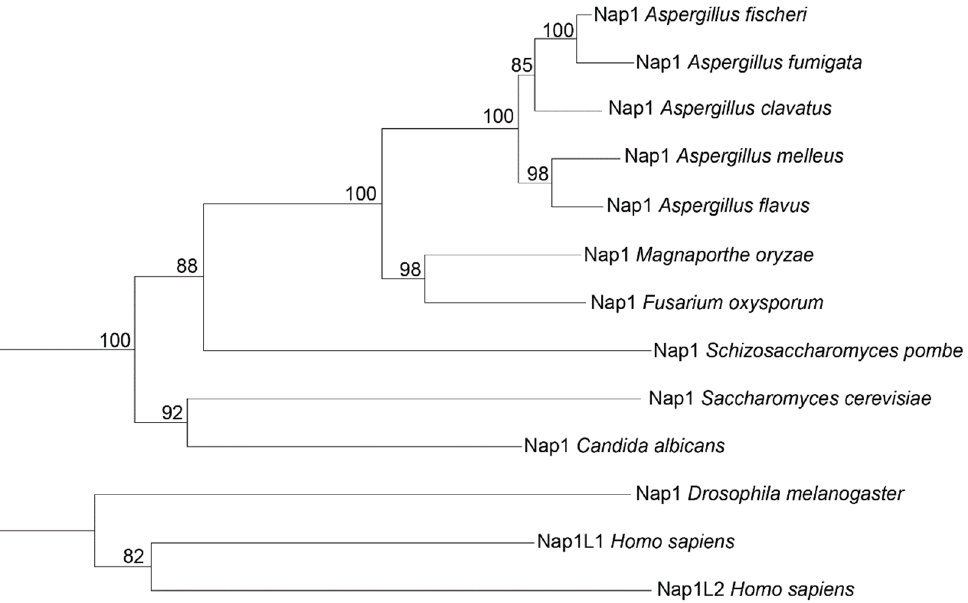
Figure 1. Nap1s are conserved in eukaryotes. Alignment tree of MoNap1 and Nap1 in S. cerevisiae (NP_012974.1), Drosophila melanogaster (NP_477128.1), Homo sapiens (XP_016874829.1, NP_068798.1), Candida albicans (XP_718658.1), Schizosaccharomyces pombe (NP_587838.1), Aspergillus melleus (XP_045950078.1), Aspergillus clavatus (XP_001273890.1), Aspergillus fischeri (XP_001266074.1), Aspergillus flavus (QRD88693.1), Aspergillus fumigatus (XP_754077.1), and Fusarium oxysporum (XP_031048533.1).